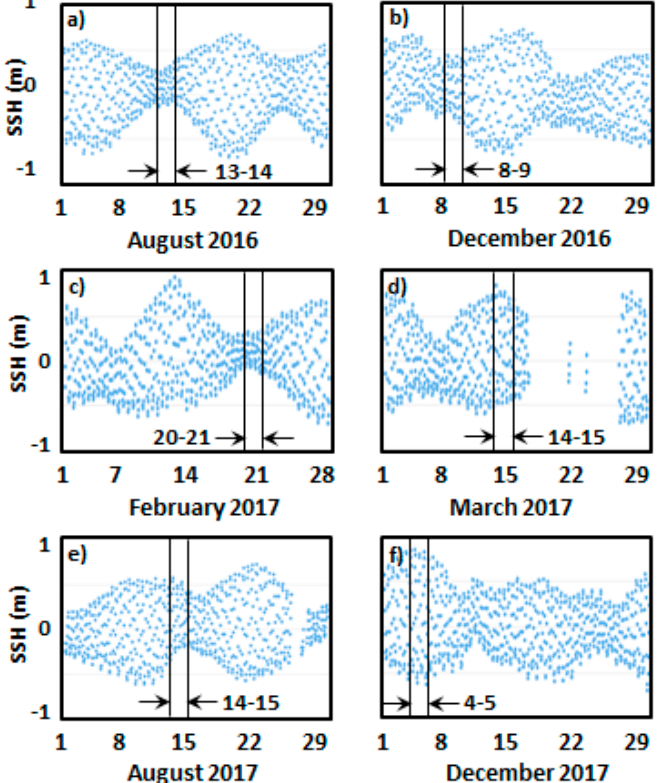
Figure 9. Monthly time series of hourly-averaged sea surface height (SSH) provided by Tarifa tide-gauge (Figure 1b). 2-day episodes of permanent inflow reversal are marked with black boxes.